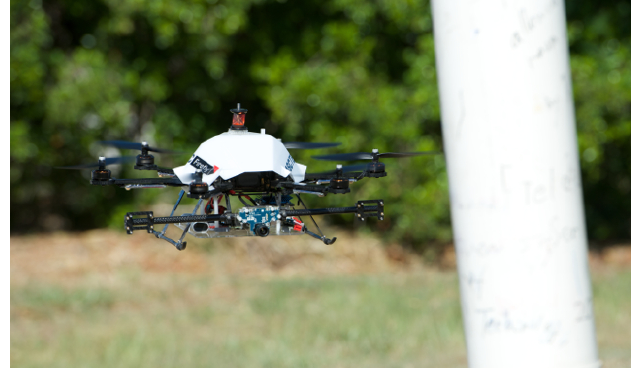
Figure 1. The vertical take-off and landing (VTOL) platform used for our pole inspection experiments. It includes a front-facing camera, downward-facing ultrasonic sensor and an onboard inertial measurement unit (IMU) for attitude control. All processing occurs onboard using a quad-core Acorn Risc Machine (ARM) Cortex-A9